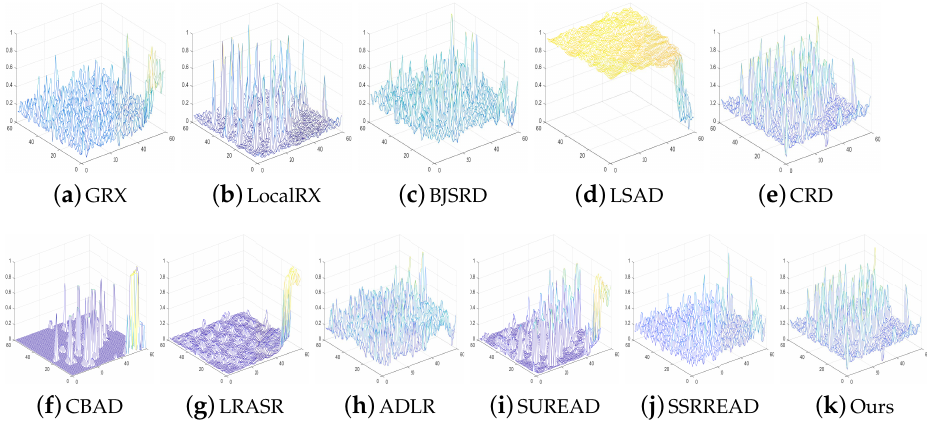
Figure 14. 3-D mesh of the detection algorithms for the Sandiego60